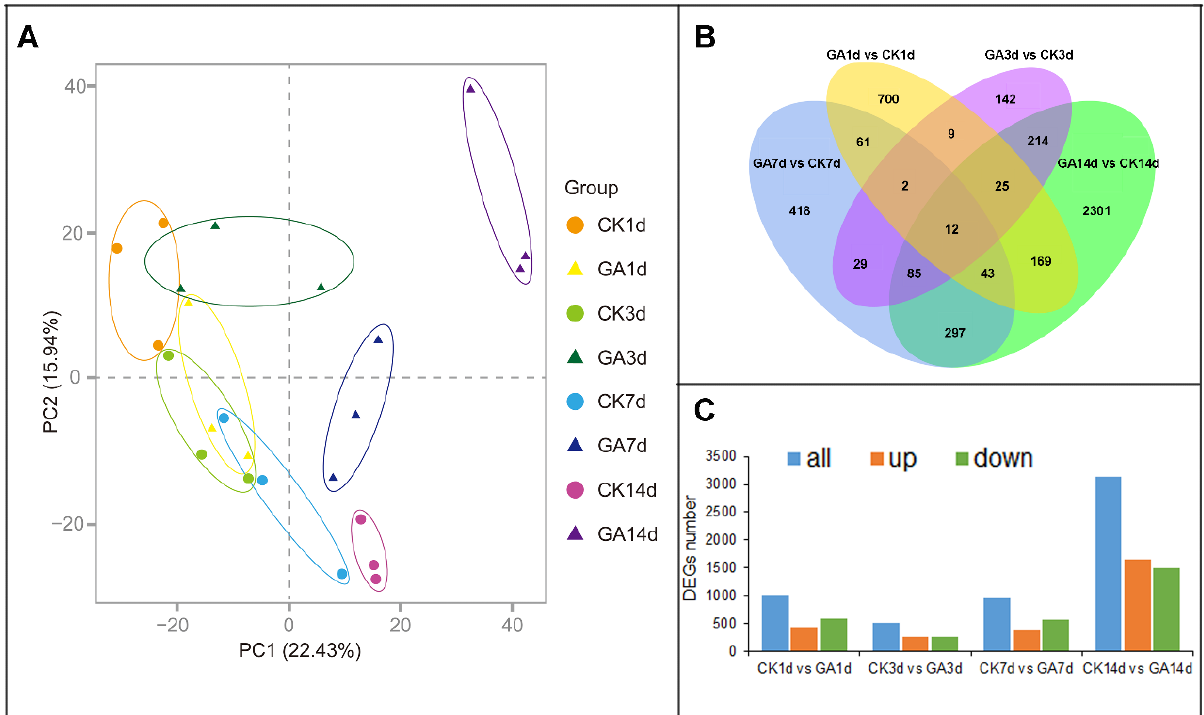
Figure 2. RNA-seq data analysis of the second internode from CK group and GA group in N. cadamba . ( A ) Principal component analysis (PCA) plots of RNA-seq data from N. cadamba second internode at 1 d, 3 d, 7 d and 14 d of CK group and GA group. ( B ) Venn diagram showing DEGs common or unique of the four comparative combinations (CK1d vs. GA1d, CK3d vs. GA3d, CK7d vs. GA7d, CK14d vs. GA14d). ( C ) DEGs analysis from RNA-seq data (both up- or down-regulated) for each comparative